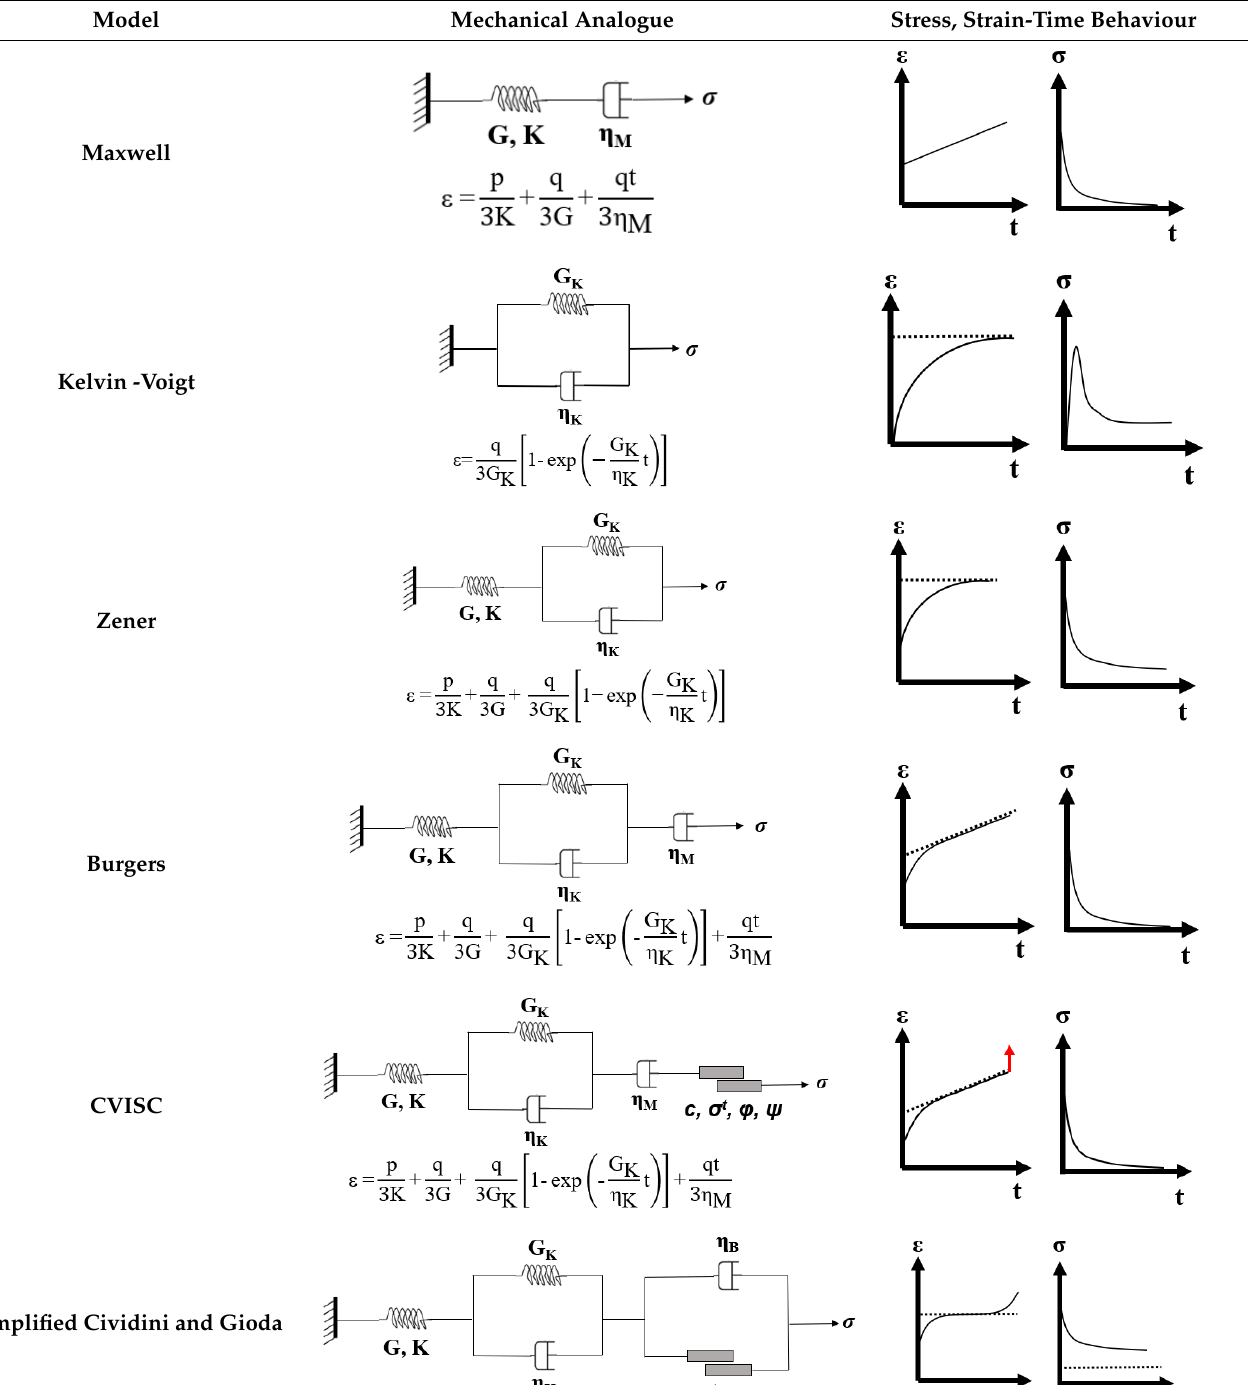
Table 2. Visco-elastic-plastic rheological models with their associated mechanical analogues; analyti- cal solutions; and stress, strain–time behaviour, modified from [18]. Note that G, K, G K , η K , and η M denote the shear modulus, bulk modulus, Kelvin viscosity, and Maxwell viscosity, respectively, and p, q, t, and ε denote mean stress, deviator stress, time, and strain, respectively.